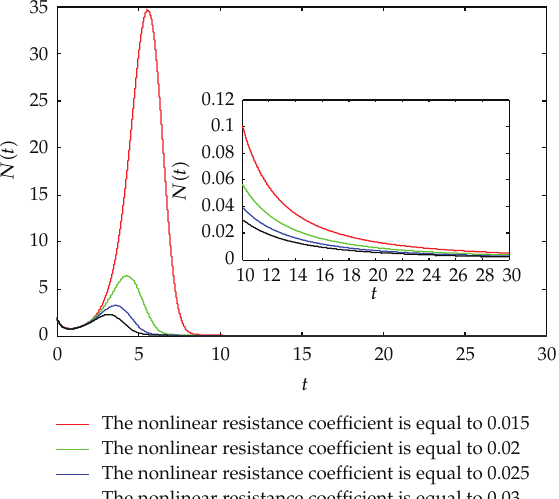
Figure 1: The trajectory curve of credit risk contagion where 𝜇 = 0.03 .